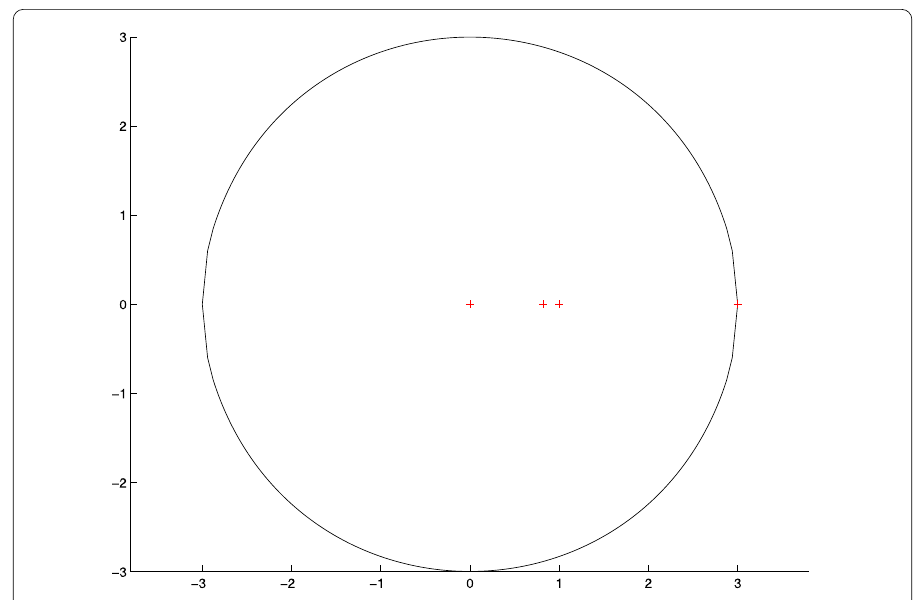
Figure 2 The singular value inclusion set ϒ S ( A ) and the exact singular